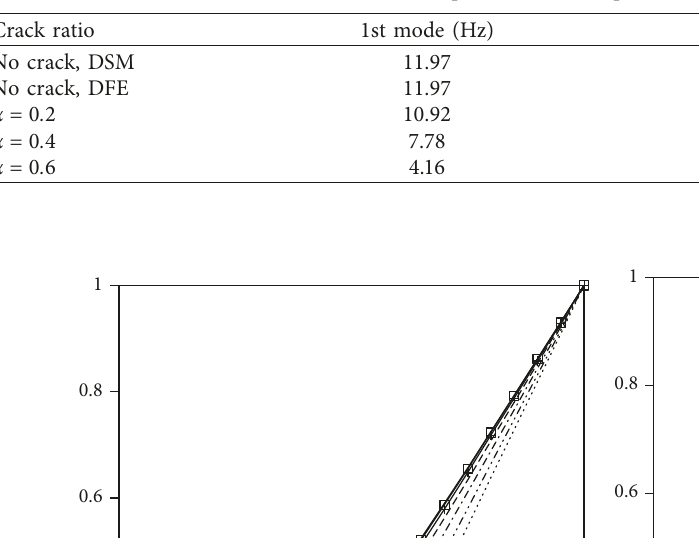
Table 1: Natural frequencies of a composite beam with a crack at